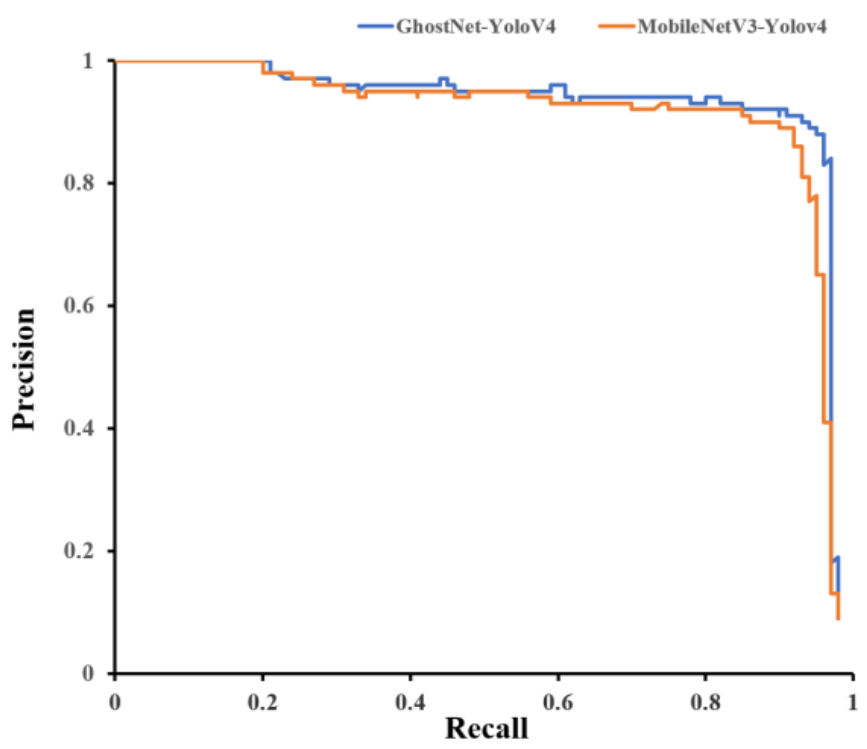
Figure 9. The Precision-Recall curves using different backbone networks.